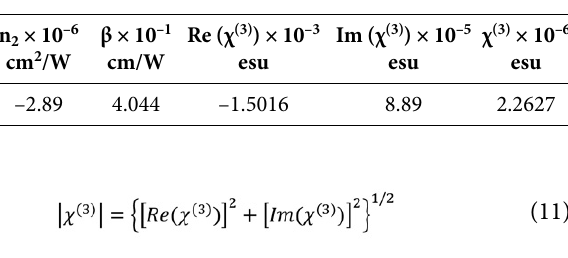
Table 1. Calculated third order nonlinear optical parameters of the title compound